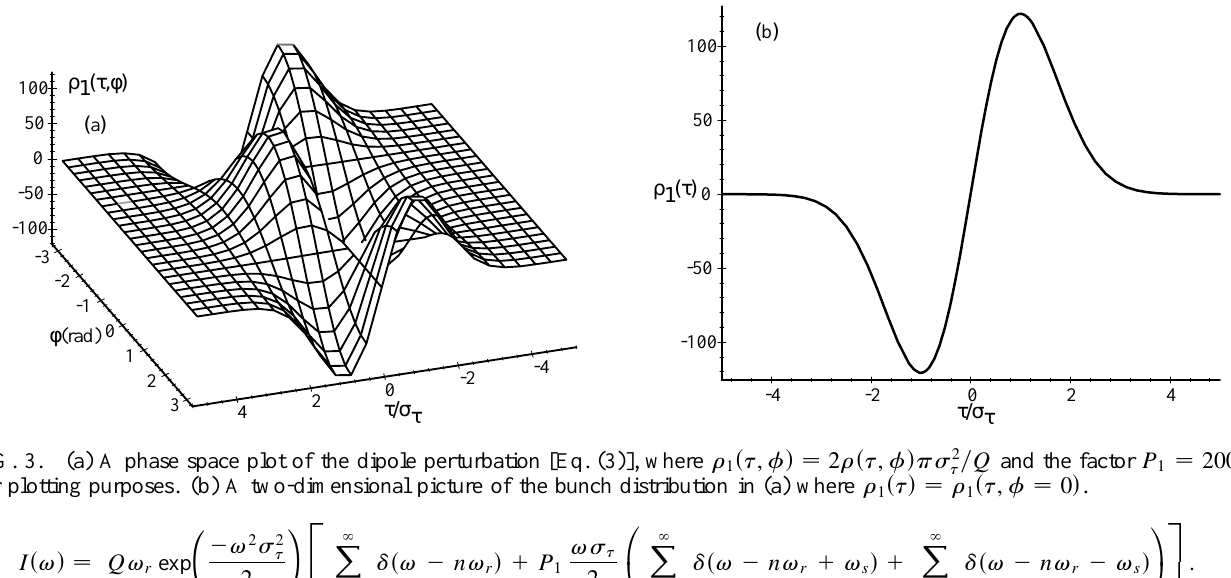
(cid:3) Q and the factor P (cid:1) 200 1 t